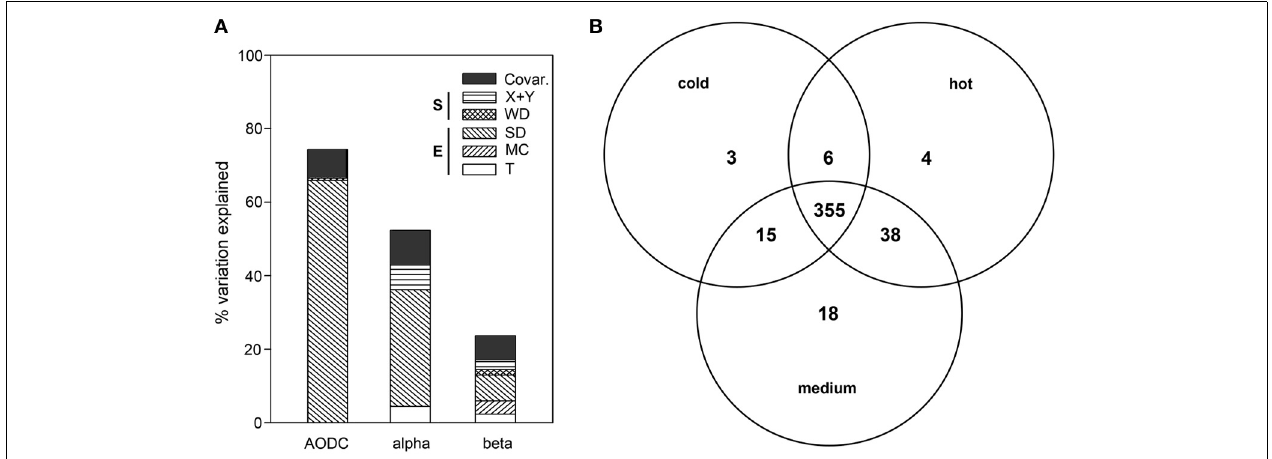
FIGURE 4 | (A) Partitioning of the variation in total cell numbers (AODC), bacterial OTU numbers (alpha-diversity) and ARISA bacterial community structure (beta-diversity) as a function of environmental and spatial parameters. The plot depicts the percent explained variation by each significant contextual parameter. Environmental variables (E) included T